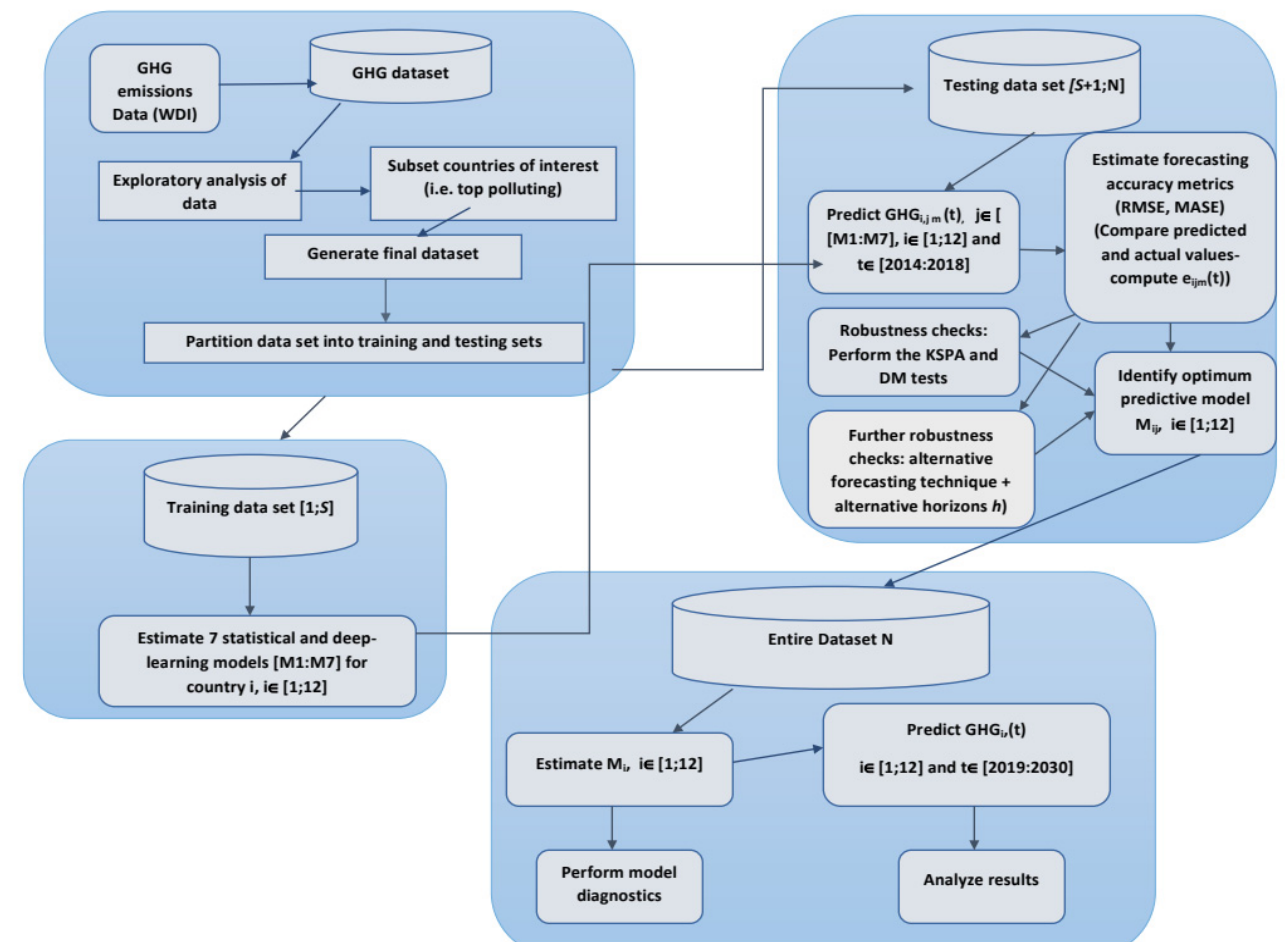
Figure 9. The conceptual framework of the study.